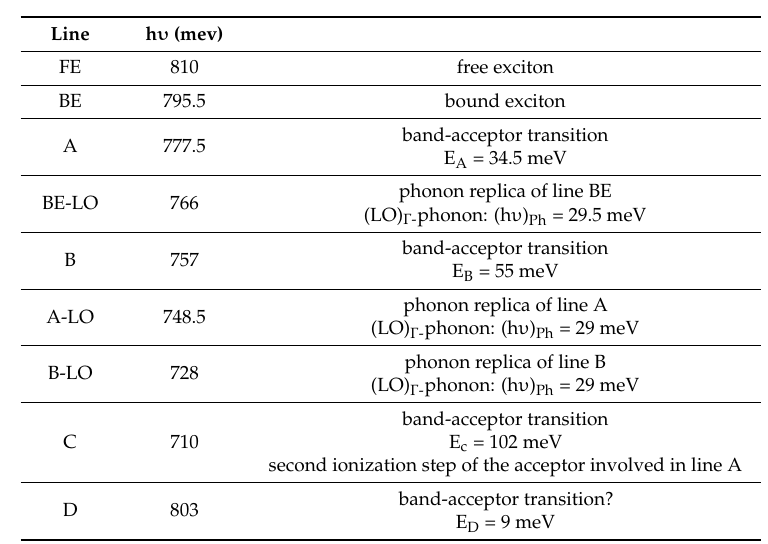
Figure 6 . Experimental photoluminescence (PL) data for undoped GaSb. ( a ) PL spectrum of GaSb sample W4, grown from a stoichiometric melt. p 300 = 1.8 × 10 17 cm − 8 , T = 2 K; ( b ) PL spectrum of GaSb sample W7, grown from an antimony rich melt. p 300 = 3.5 × 10 16 cm − 3 , T = 2 K; Reproduced with permission from [16], copyright Wiley-VCH (1972). Table 3. Energetic positions and corresponding interpretations for GaSb. Reproduced with permission from Jakowetz et al., Physica Status Solidi; published by the Weinheim, Germany: Wiley-VCH, 1972 [16].